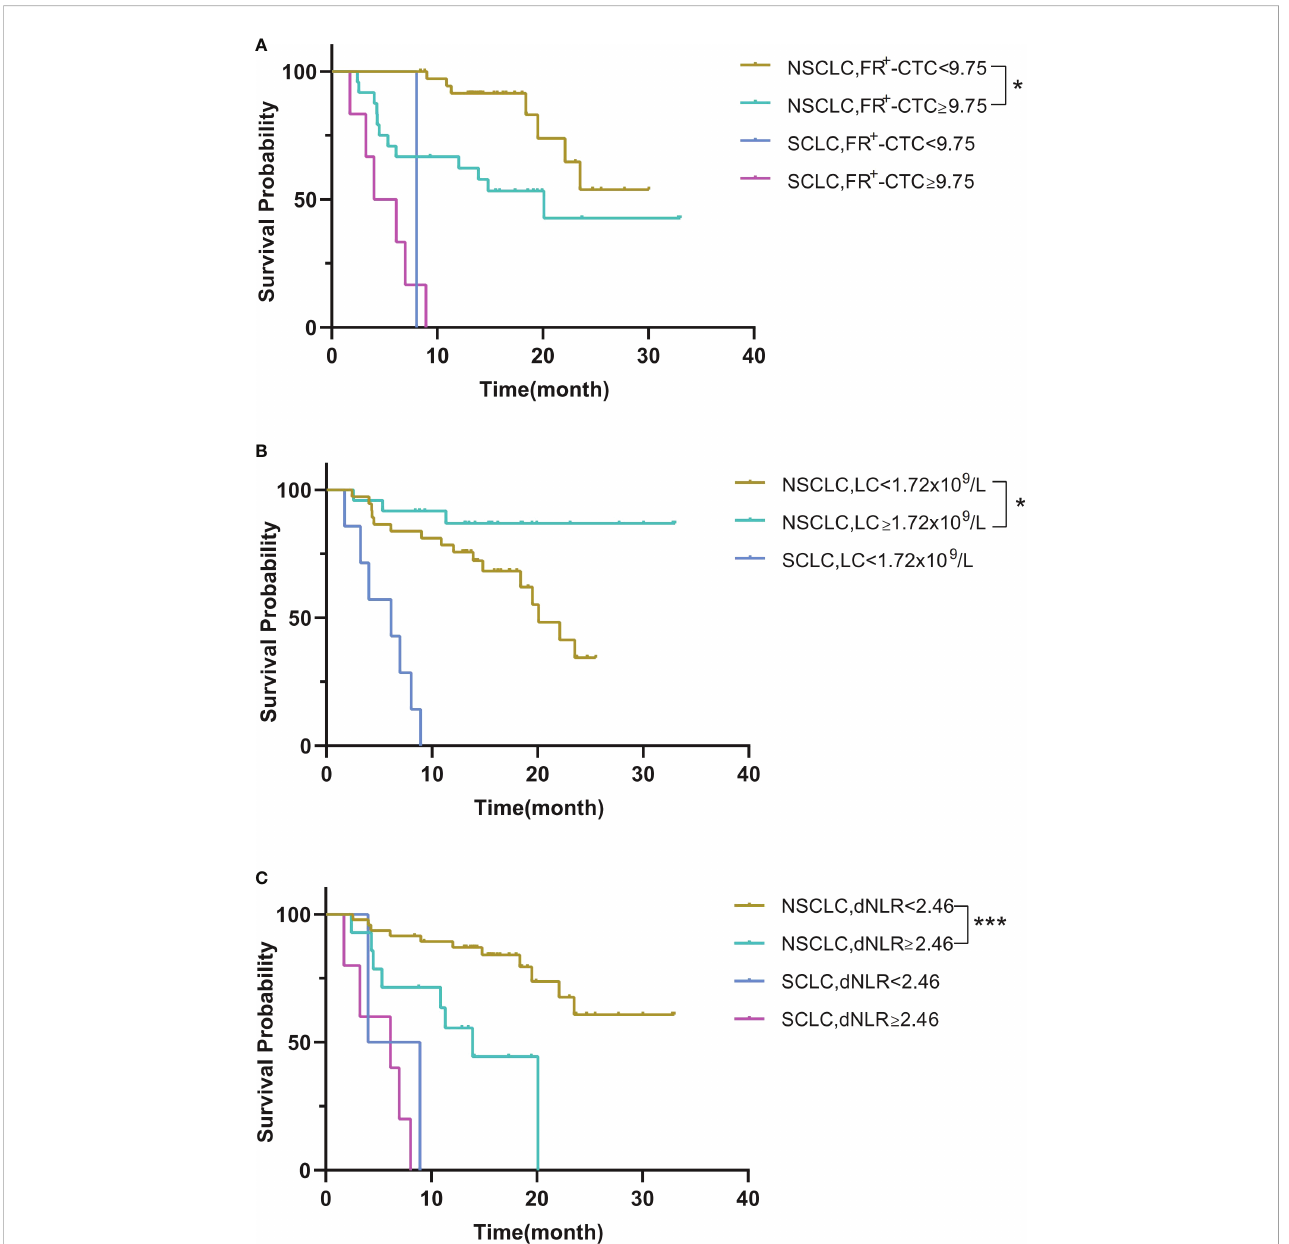
FIGURE 2 (A) Kaplan – Meier curves for survival probability according to the FR + -CTC count between NSCLC and SCLC. (B) Kaplan – Meier curves for survival probability according to the LC between NSCLC and SCLC. (C) Kaplan – Meier curves for survival probability according to the dNLR between NSCLC and SCLC. *P < 0.05, **P < 0.01, ***P <